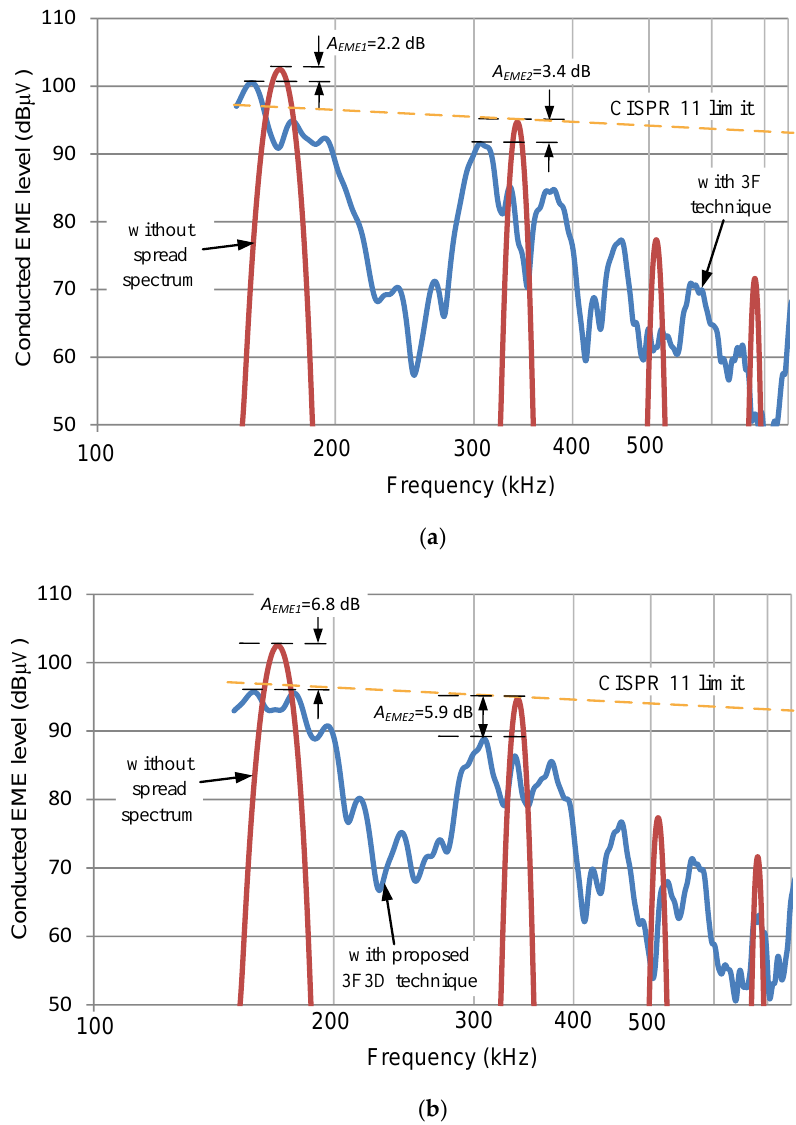
Figure 10. Comparison of spectra of the conducted EME (150–750 kHz) from the WPT system without the spread spectrum and with the spread spectrum based on 3-frequency technique ( a ) and based on the proposed 3F3D spread spectrum technique ( b ). Note: f m = 10.6 kHz, f 1 = 151.5 kHz, f 2 = 170.6 kHz, f 3 = 190.1 kHz, RBW = 9 kHz. Also note: (1) if the spread spectrum was not used, then D = 34%; (2) if the 3-frequency technique was used, then D 1 = D 2 = D 3 = 34%; and (3) if the proposed 3F3D technique was used, then D 1 = 30%, D 2 = 50; D 3 = 30%. The results are shown for the worst-case peak EME levels.